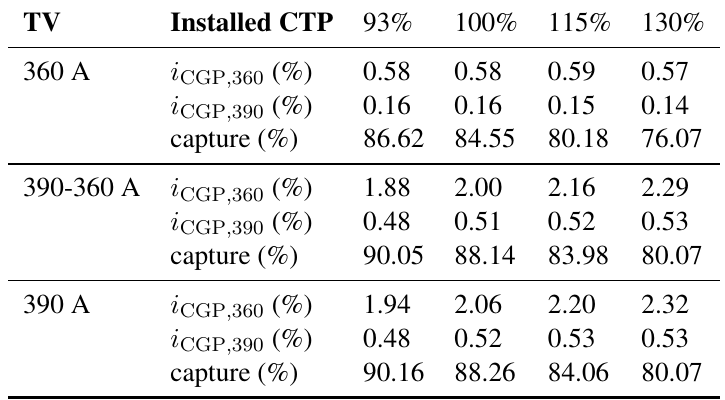
Table 10. Effect of installed control point (CTP) power with controlled action on CTPs. CGP, congestion point.